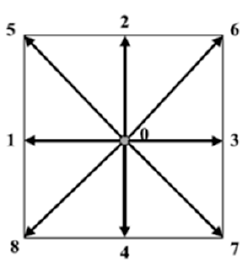
Figure 2. Typical D 2 Q 9 model. Here, D is the dimension and Q is the number of speed 𝑄 Figure 2. Typical 𝐷 model. Here, 𝐷 is the dimension and 𝑄 is the number of speed 2 9 components.